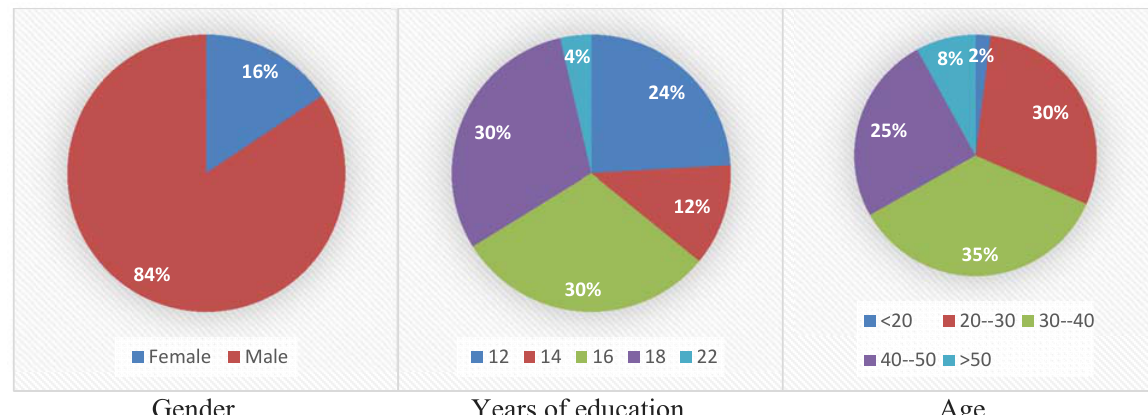
Fig. 1. Personal characteristics of the participants